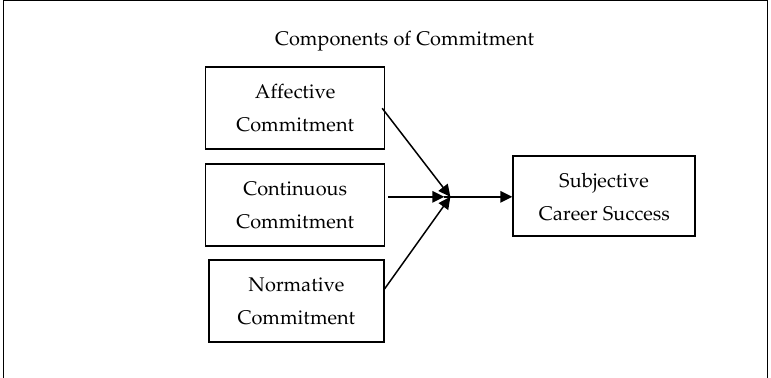
Figure 1. The Conceptual Model of the Research.